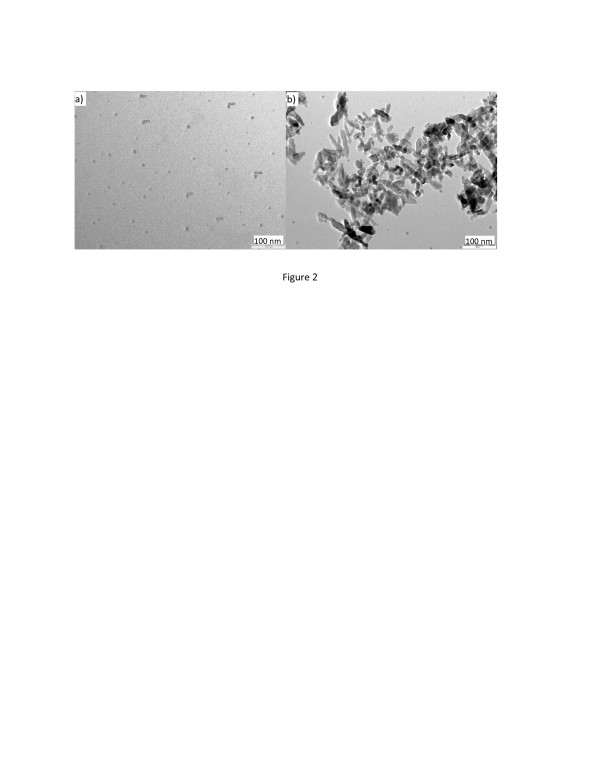
TEM images of as-synthesized bare TiO2NPs (a) and the hydrothermally treated TiO2NPs (b). The latter (in a mixture of EtOH/H2O = 1:1.5 at 150 °C for 24 h) are from a simple stoichiometric non-synchronous feeding where the equivalent mole of Li2O and TiCl4 solutions were fed at a molar rate of MLi2O/MTiCl4 = 2:1.